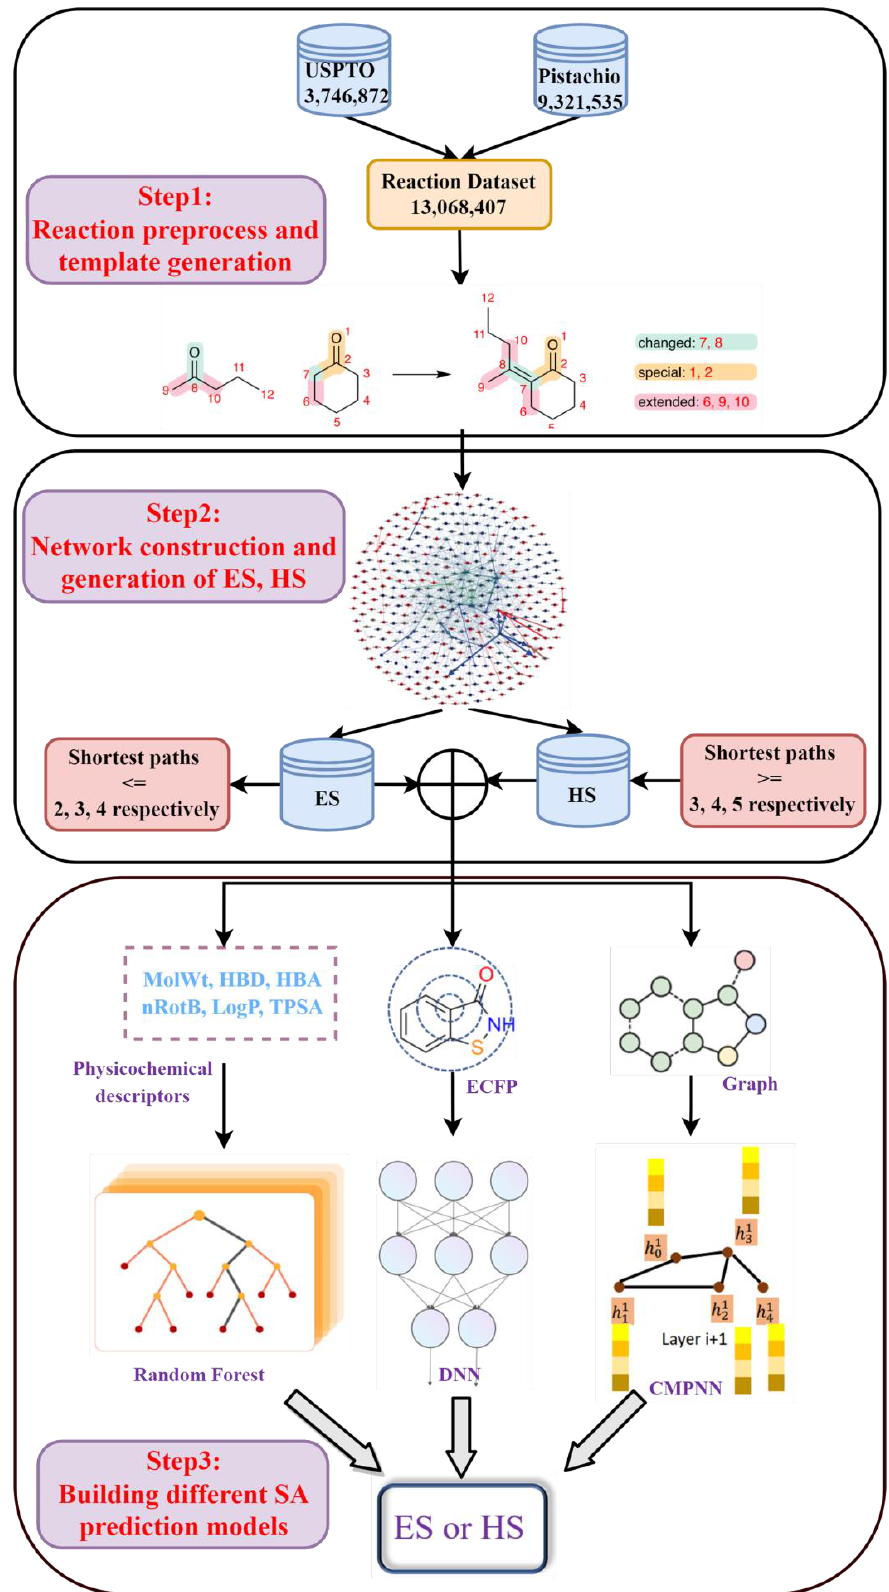
Figure 1. The workflow of chemical reaction processing. It was divided into three steps: (1) reaction preprocess and template generation; (2) network construction and generation of ES, HS datasets; (3) building different SA prediction